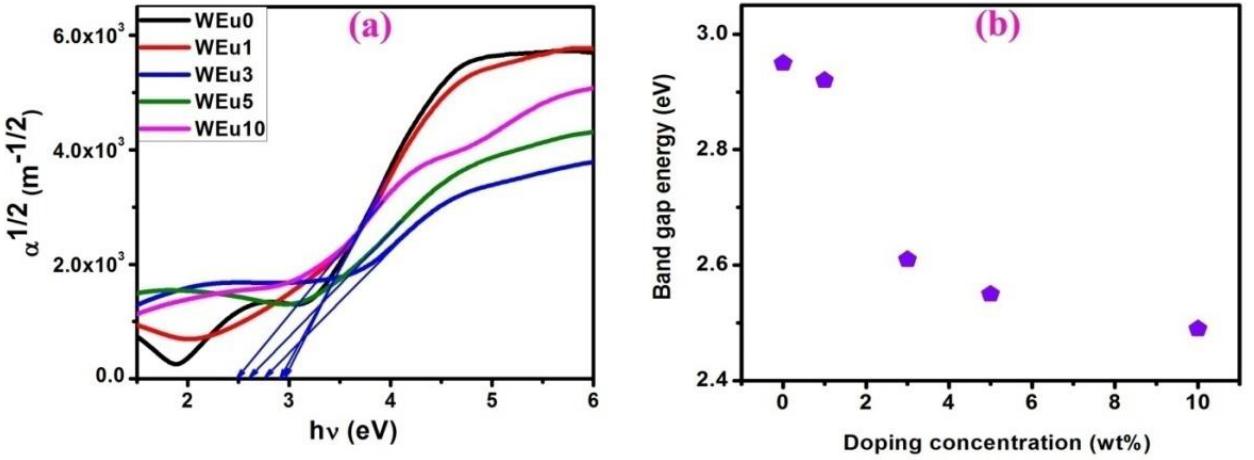
21  Figure 11. ( a ) α 1 2 vs. h ν graphs of the un-doped and Eu 3+ -embedded WO 3 films; ( b ) change of band Figure 11. ( a ) vs.  h graphs of the un-doped and Eu 3+ -embedded WO 3 films; ( b ) change of gap energy with respect to Eu 3+ -doping band gap energy with respect to Eu 3+ -doping content.